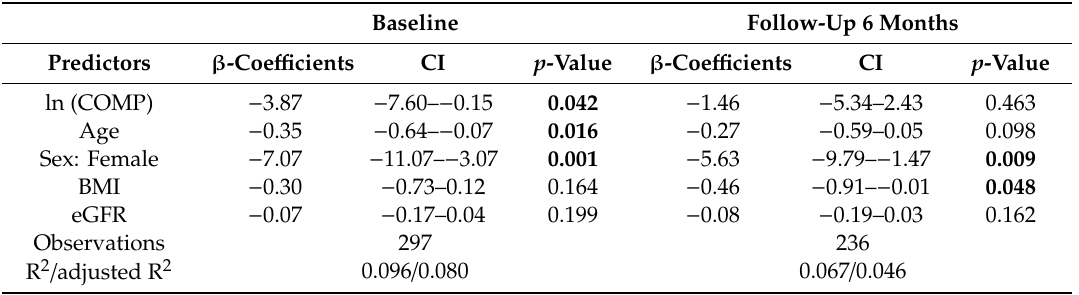
Table 3. FFbH Hannover Functionality Status of patients with knee OA. Baseline and follow-up six months after surgery. Multiple linear regression model adjusted for age, sex, BMI, and eGFR. Significant associations are highlighted in bold.